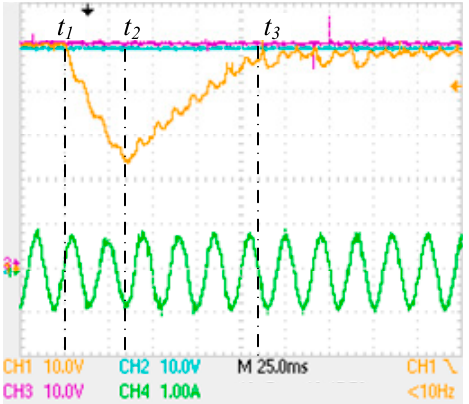
voltage of Module 2; CH3: DC-link voltage of Module 3; CH4: AC-link current of cascaded modules).